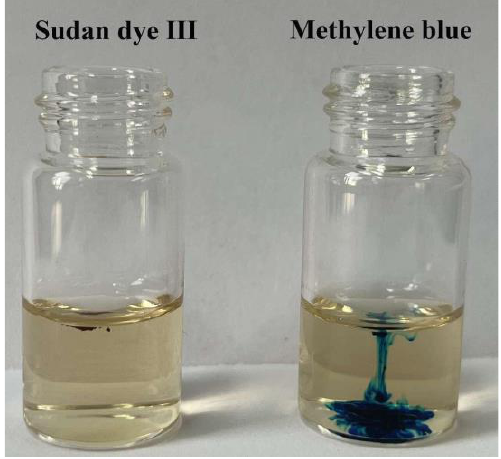
Figure 4. The diffusion results of Sudan dye III (left) and methylene blue (right) in the CH microemulsion.